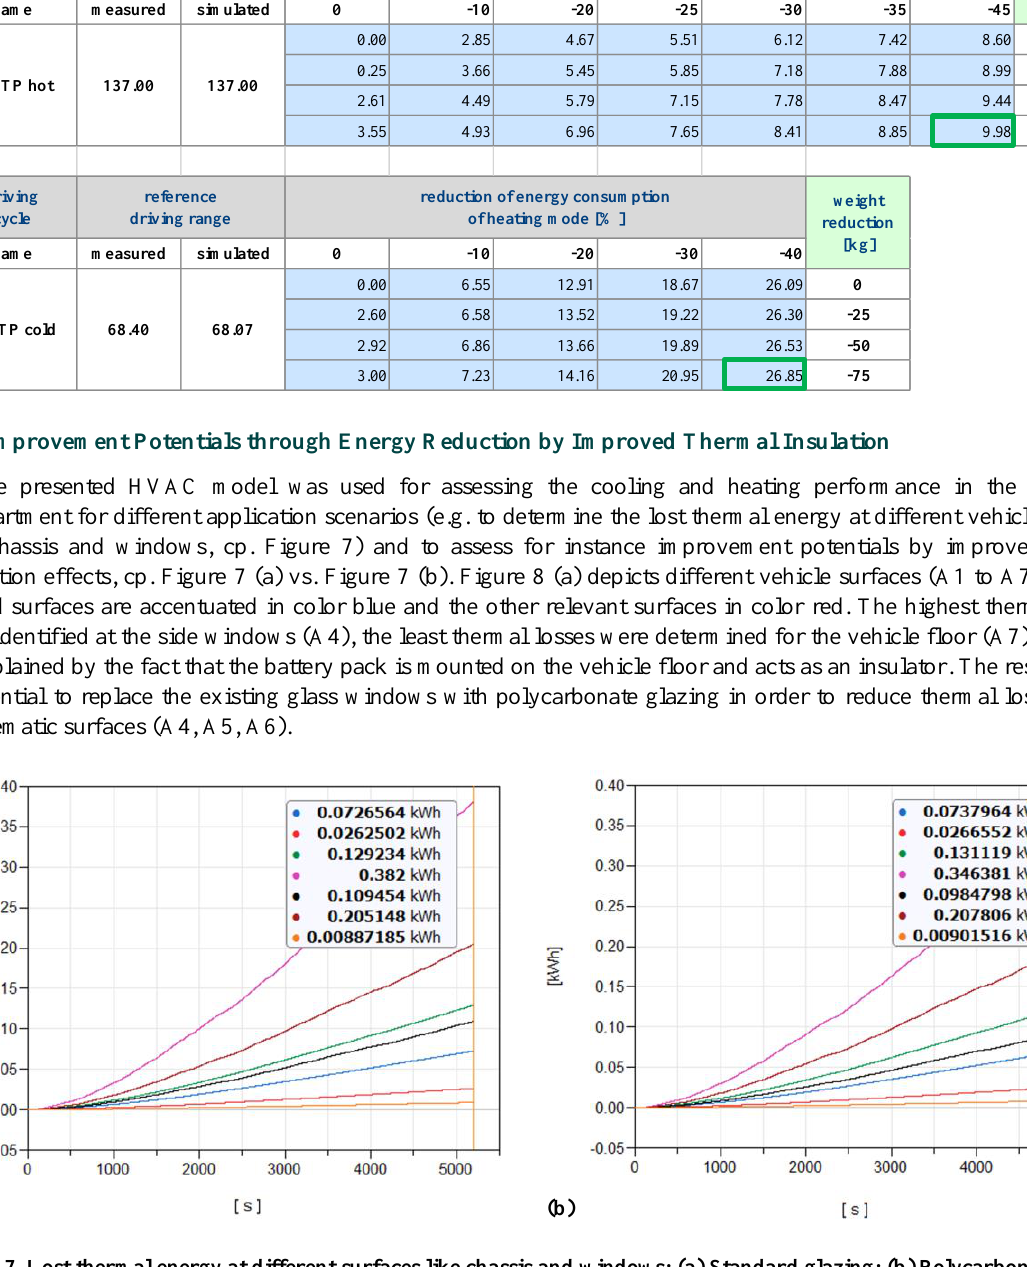
Figure 7. Lost thermal energy at different surfaces like chassis and windows: (a) Standard glazing; (b) Polycarbonate